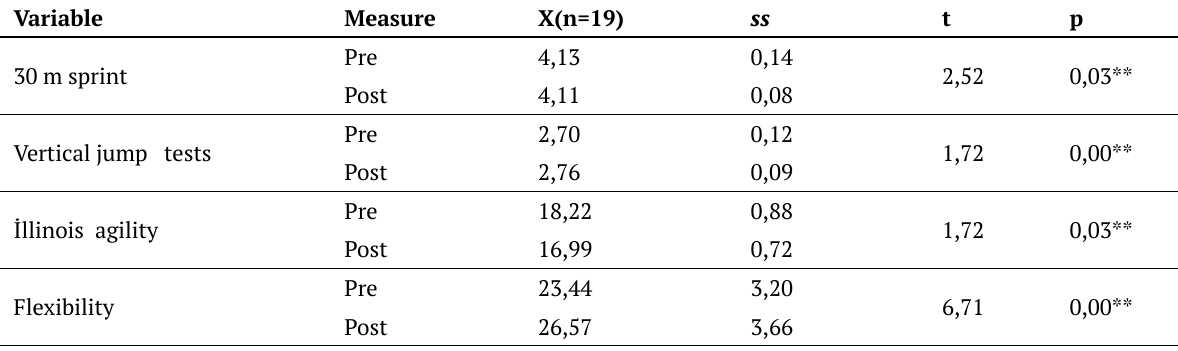
Table 5. Analysis results for physical performance “pre-test and post-test” values of footballers doing pilepliometric training.